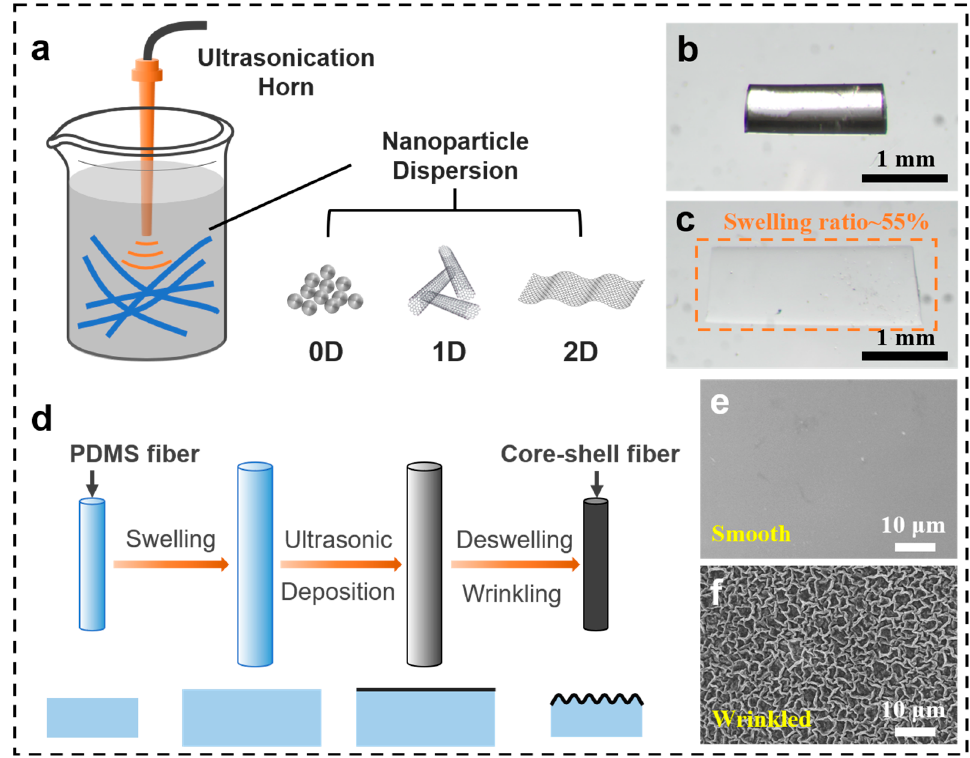
Figure 1. ( a ) Schematic illustration of ultrasonic-assisted deposition method. ( b , c ) Optical photo- graphs of PDMS fiber before and after swelling in cyclohexane, respectively. ( d ) Schematic illustra- tion of surface wrinkling mechanism of the fiber. ( e , f ) Surface SEM images of pristine PDMS fiber and CNTs@PDMS core-shell fiber.